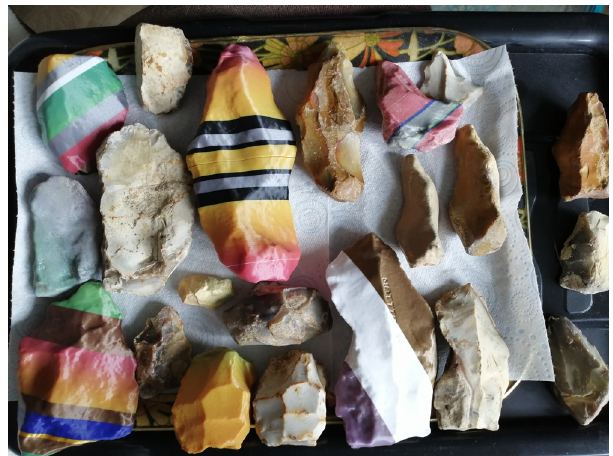
Figure 15: Phygital fi nds tray: Interlaced corn and fl int assemblage.